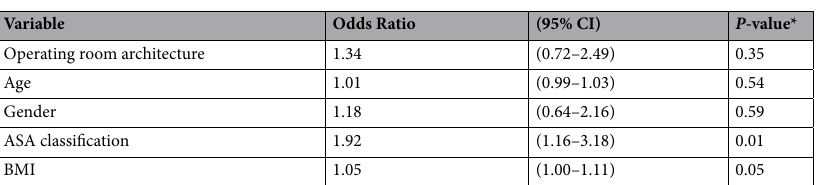
Table 1. Surgical site infection in the open- vs closed-plan operating room architecture (without subspecialties). *Logistic regression analysis. % percent, CI confidence interval, ASA American society of anesthesiologists, BMI body mass index.